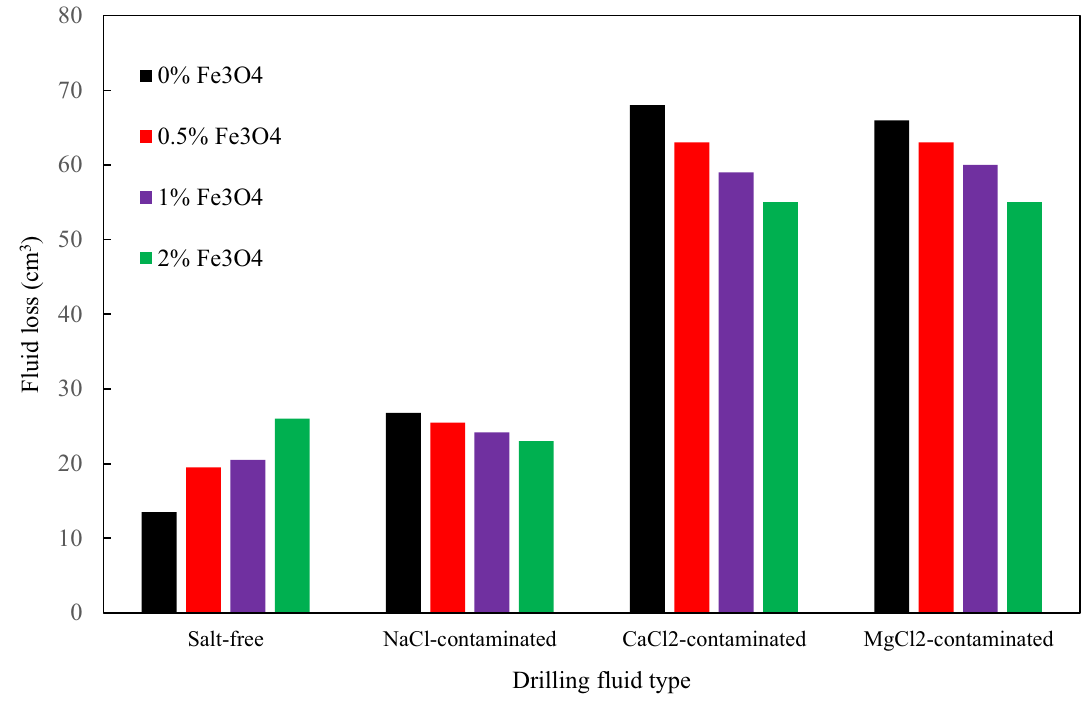
Fig. 5 Fluid loss for salt-free and salty drilling fluids in the presence of different Fe